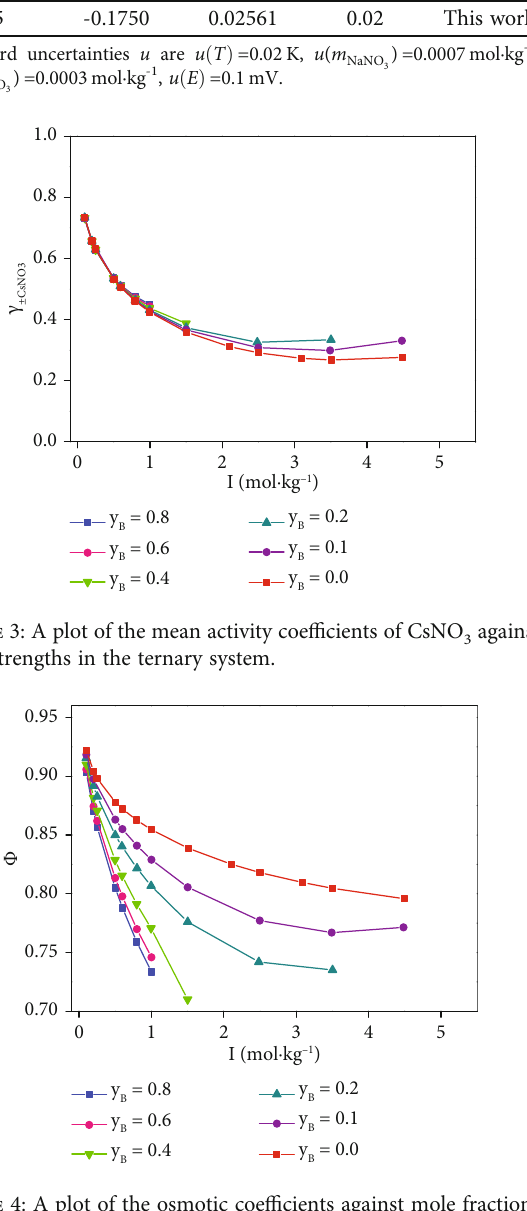
Figure 4: A plot of the osmotic coe ffi cients against mole fractions in the ternary system.